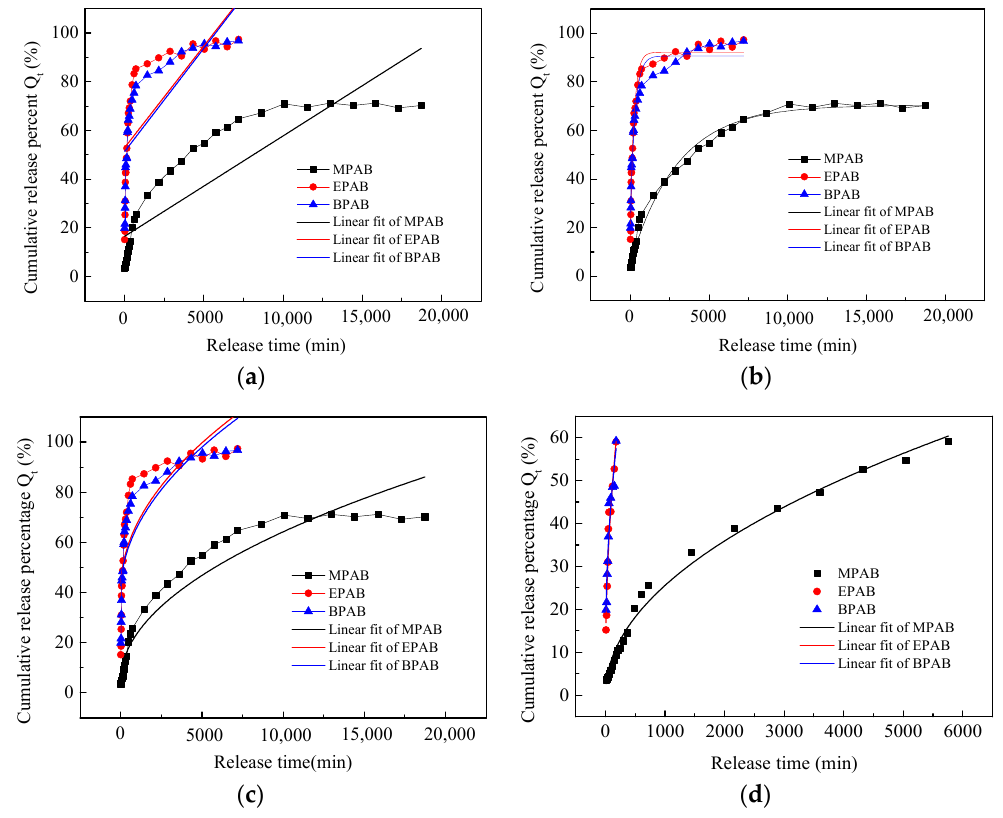
Figure 3. The release kinetics model fitting curves of MPAB, EPAB, and BPAB drugs: ( a ) zero-order release kinetics; ( b ) fi rst-order kinetics model; ( c ) Higuchi model; and ( d ) Korsmeyer–Peppas model. Table 2. The release kinetics model fi tt ing parameters of MPAB, EPAB, and BPAB drugs. Drugs